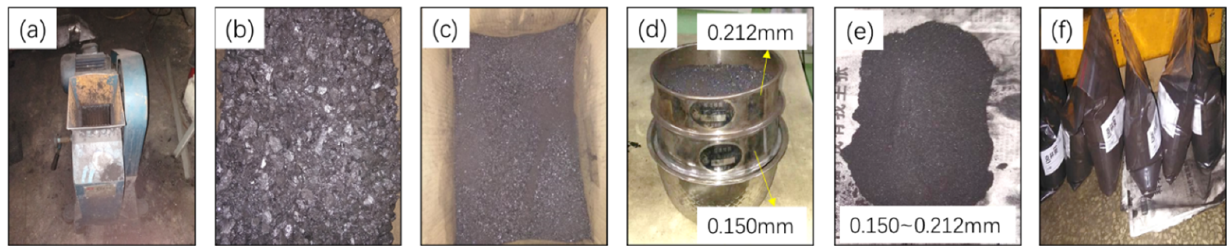
Figure 3. Preparation of coal powders. ( a ) Crushing machine; ( b ) the once-crushed particles of raw coal; ( c ) the twice-crushed coal fines of raw coal; ( d ) sieving; ( e ) coal particles after sieving; ( f ) pul- verized coal stored in bags.